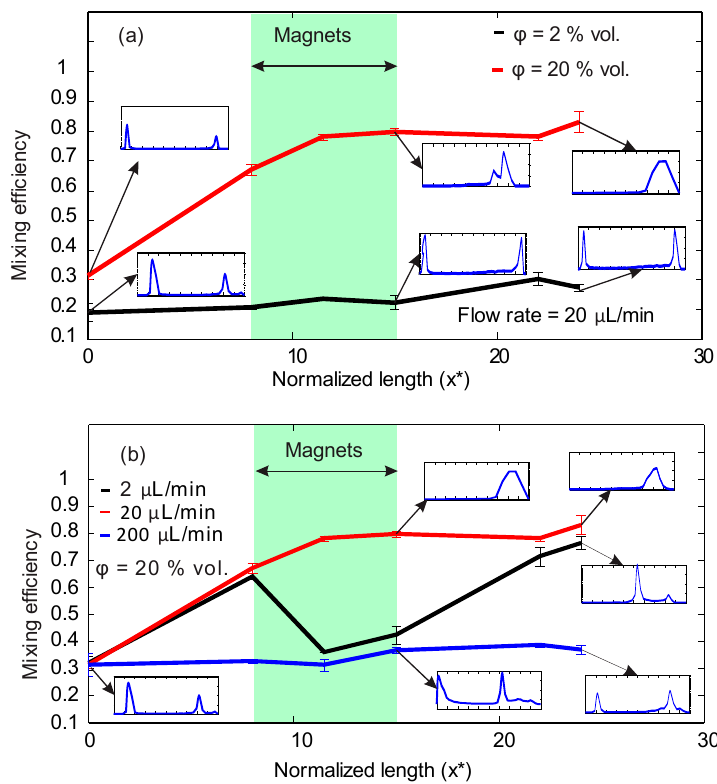
Figure 4. Mixing efficiency along the normalized channel length x * with probability distribution graphs of selected points: ( a ) Constant flow rate of 20 µL/min and ferrofluid concentrations of 2 and 20% vol.; ( b ) Constant concentration of 20% vol. and three flow rates of 2, 20, and 200 µL/min.